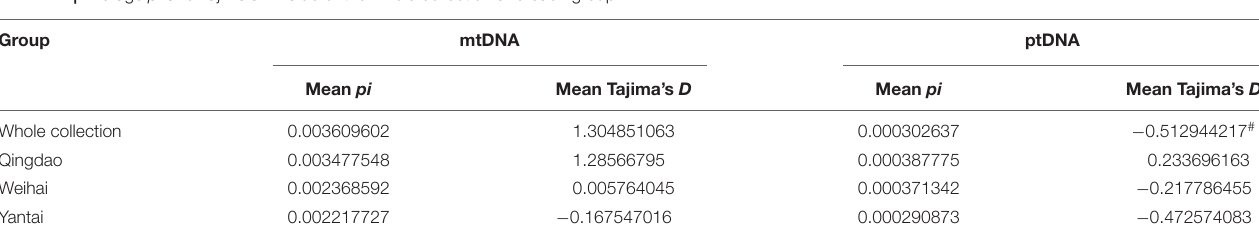
TABLE 2 | Average pi and Tajima’s D value of the whole collection and each group. Group